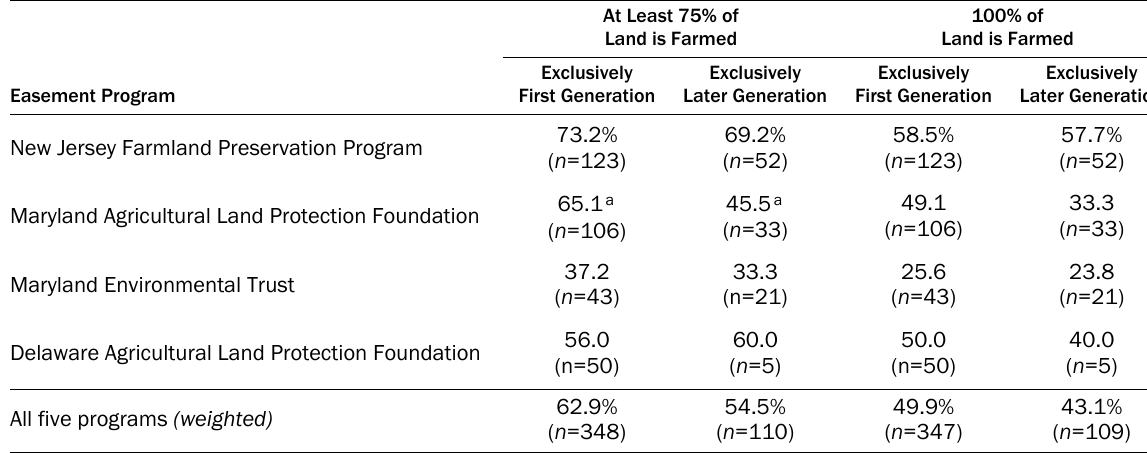
Table 3. Percentages of Owners Reporting at Least 75% and 100% of Their Preserved Land in Farming Operations, by Generation of